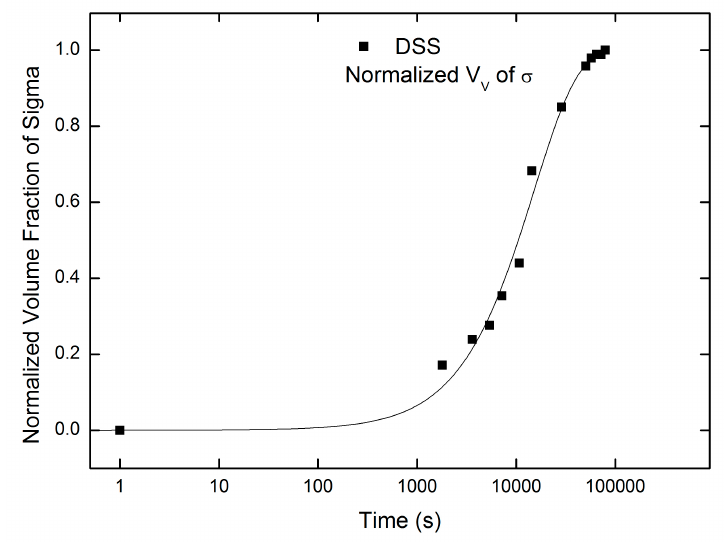
Figure 3. Normalized volume fraction of the sigma phase as a function of the aging time, at 800 °C. The solid line represents the fit of the experimental data to Equation (4) (Johnson-Mehl, Avrami, and Kolmogorov (JMAK)).